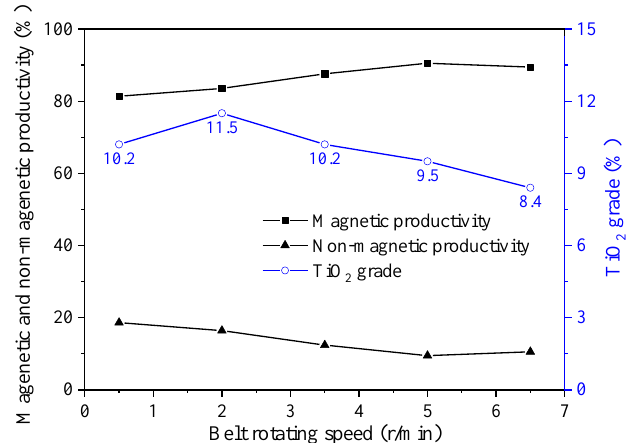
Figure 12. Effect of belt rotating speed on separation performance 6.at a magnetic induction of 1.0 T and a rinsing water consumption of 9.5 and a rinsing water consumption of 9.5 L/min.